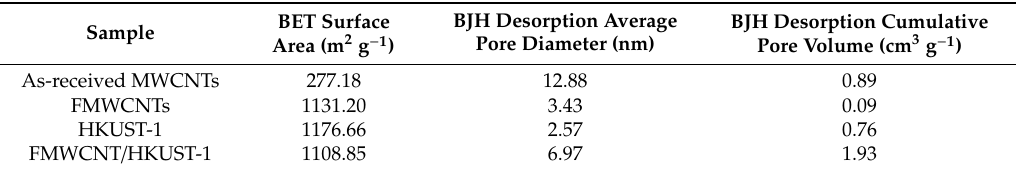
Table 2. Textural properties of HKUST-1 and the composites synthesized in this study using the hydrothermal